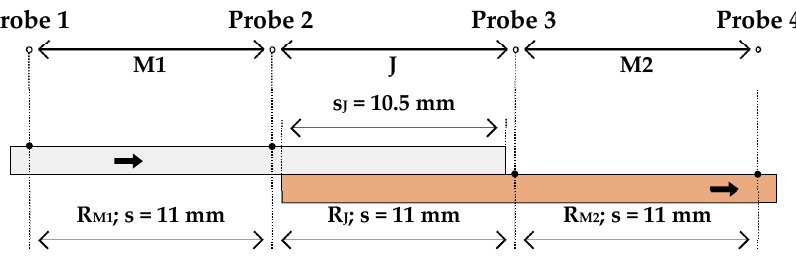
Figure 6. Schematic set-up of measuring the specimen.